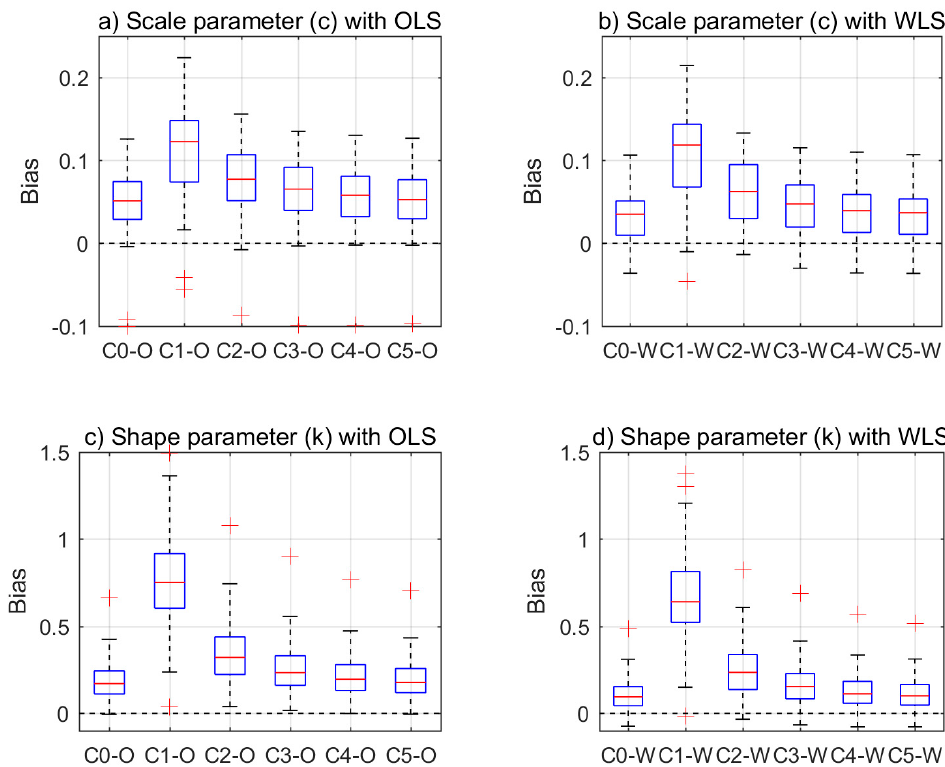
Figure 4. Boxplots of the Bias of scale (c) and shape (k) parameters of the downscaled Weibull distiribtuion with OLS and WLS methods based on the parameter estimates from the observed Weibull distribution. Note that ( a – d ) presents boxplots of scale parameter estimates with OLS, scale parameter estiamtes with WLS, shape parameter estimates with OLS, and shape parameter with WLS, respectively.